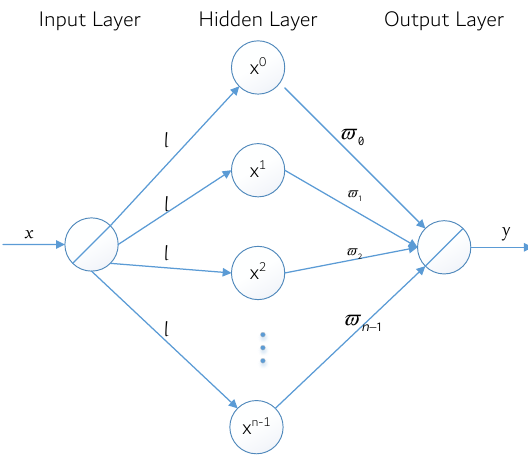
Figure 5. An improved power-excited forward neural network